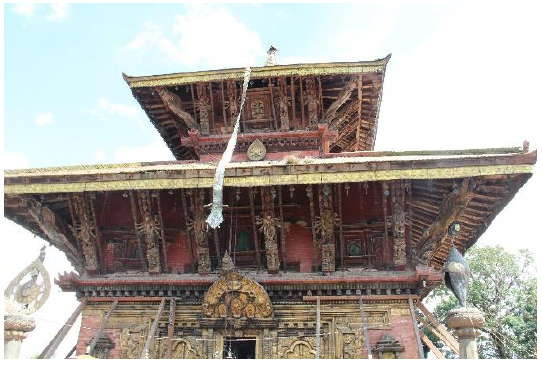
Figure 6. A monument covered by scaffolds and its 3D model produced using crowdsourced data before scaffolding.